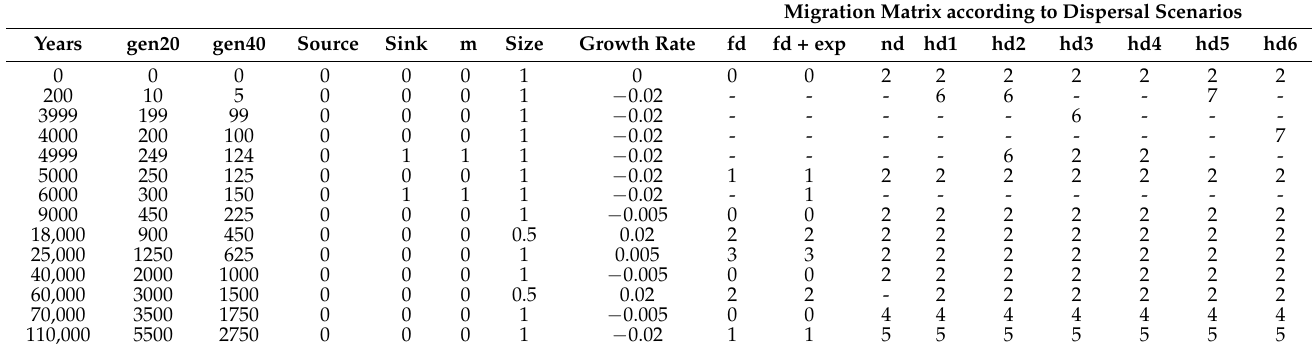
Table A1. Historical events that determine coalescence under 9 dispersal scenarios. The first three columns indicate the time of historical events in years or generations before present assuming a 20 year and 40 year generation time (“gen20” and “gen40”). Fission between demes was used to simulate rapid range expansion events. Going backwards in time, the “source” is the deme from which genes originate, “sink” is the deme to which they go, and “m” indicates the percentage of genes in the sink that originate from the source (1 = all genes). Ne is re-scaled by “size” at each historical event and by the “growth rate” per generation until the next event (negative values imply population expansion backwards in time). The migration matrix at each historical event is indicated for each dispersal scenario. fd = post-glacial faunal dispersal, fd + exp = post-glacial faunal dispersal and range expansion, nd = post-megafauna isolation, hd1–6 = post-megafauna Indigenous dispersal scenarios. Migration Matrix according to Dispersal Scenarios